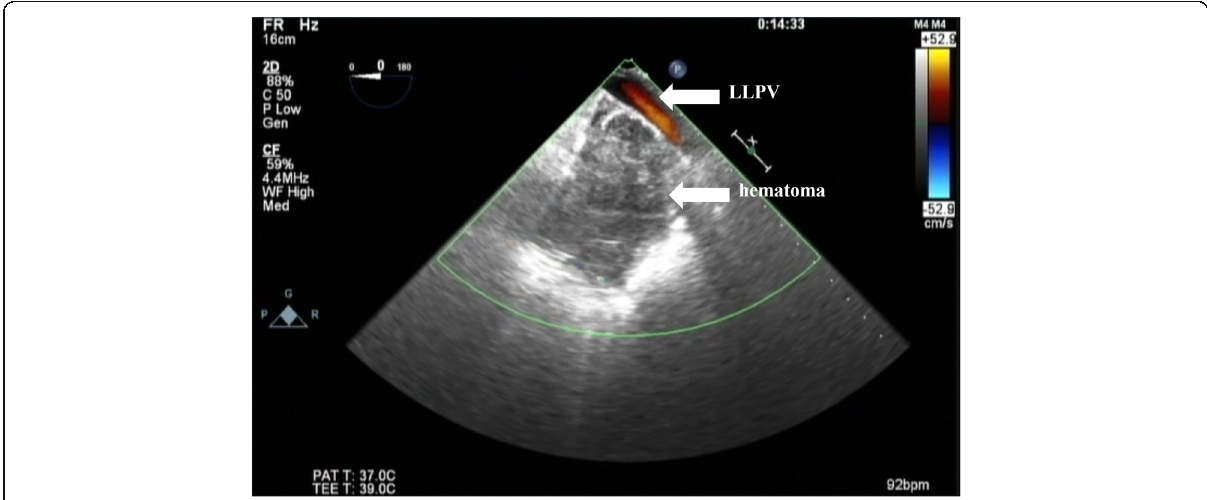
Fig. 1 Left-sided intrathoracic hematoma adjacent to the left lower pulmonary vein area. Left lower pulmonary vein flow is depicted using the color Doppler imaging mode. LLPV, left lower pulmonary